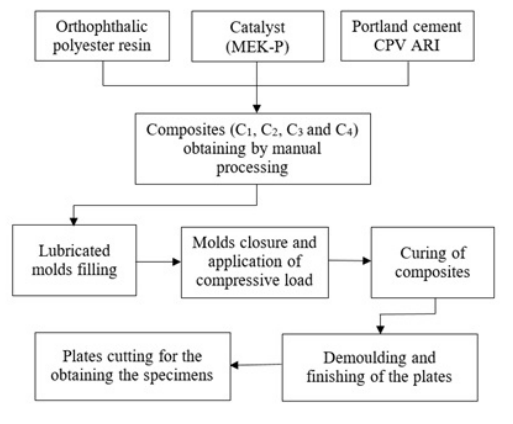
Figure 1. Steps of the manufacturing process of the